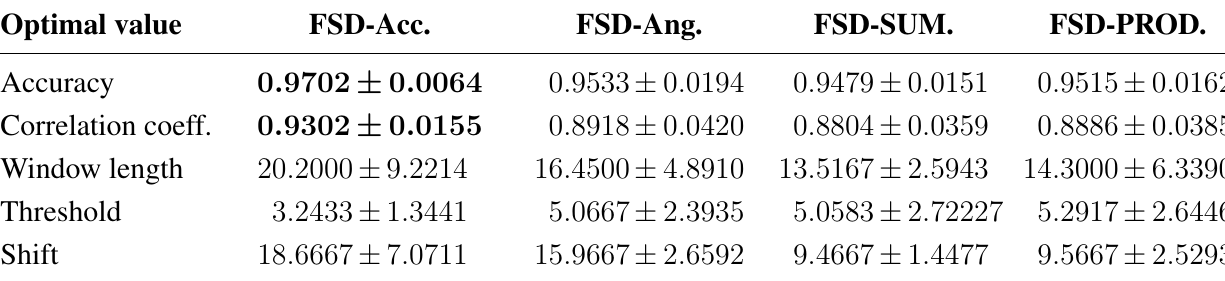
Table 8. Algorithms applied to real signals. Average Accuracy, Correlation coefficient and associated parameters (Framed Spectrum Detector).